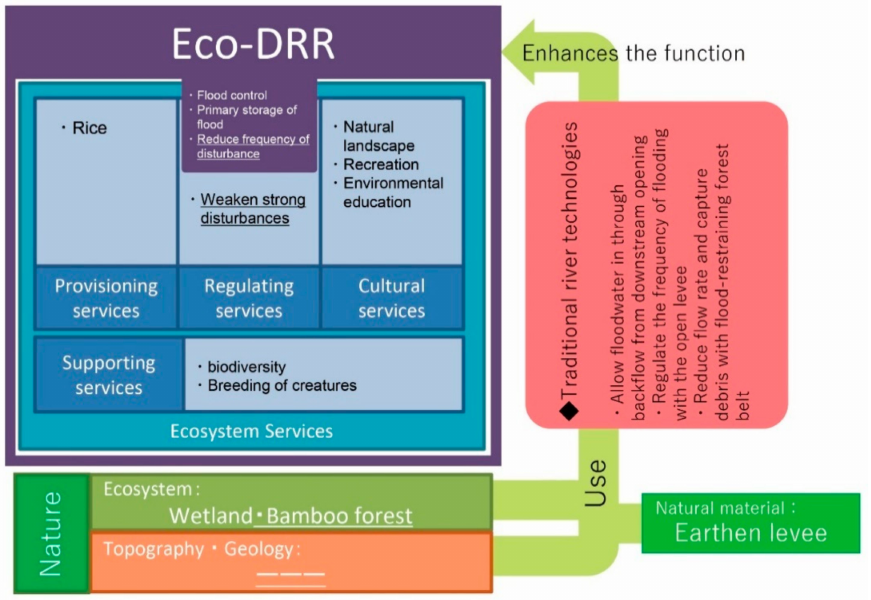
Figure 16. Eco-DRR and traditional river technology at